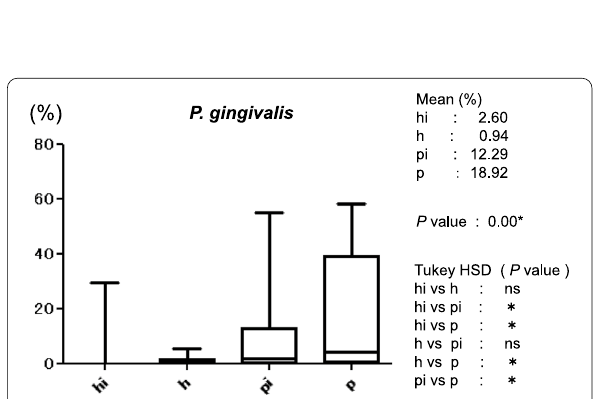
Fig. 7 Average proportion (%) of bacteria to total copy-count for Treponema